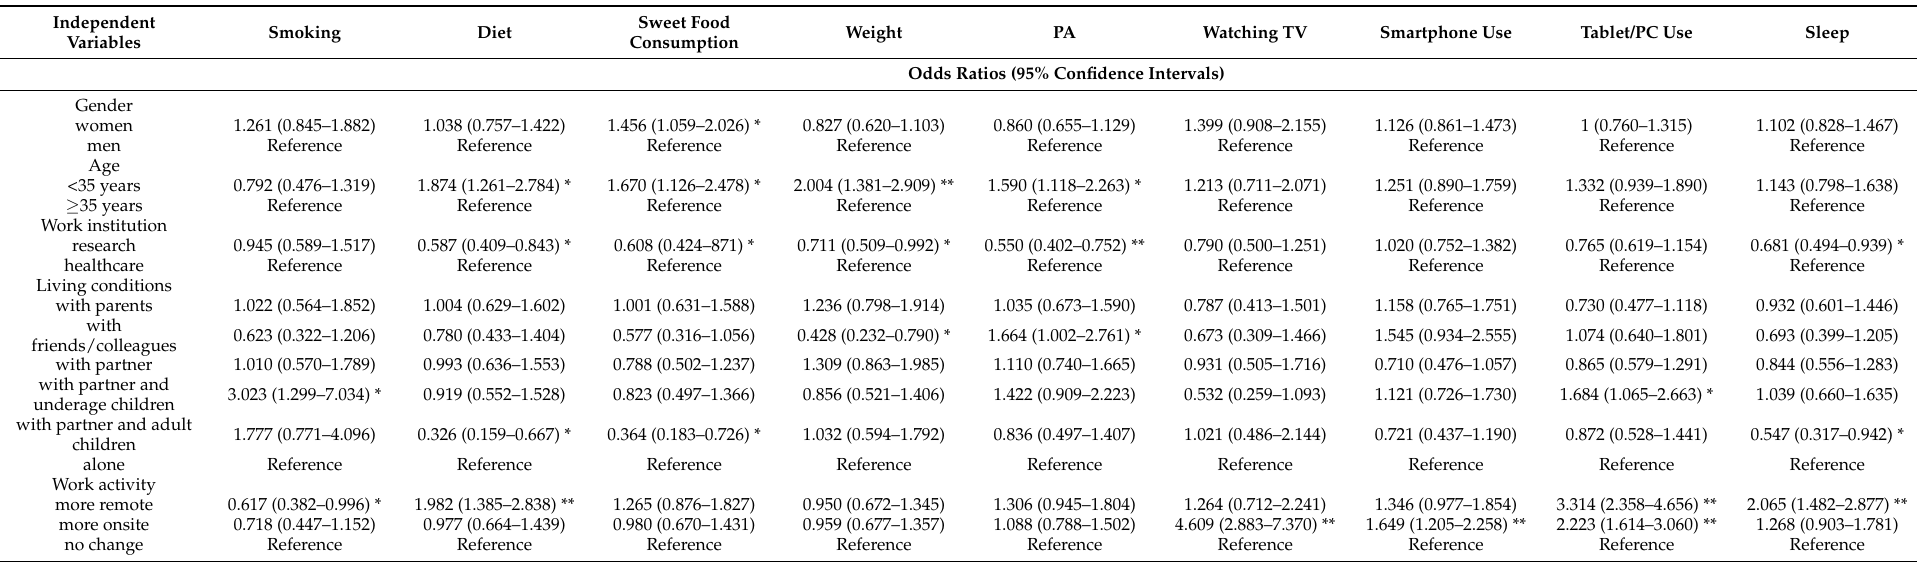
Table 4. Results of the multivariate regression analysis of lifestyle worsening during the